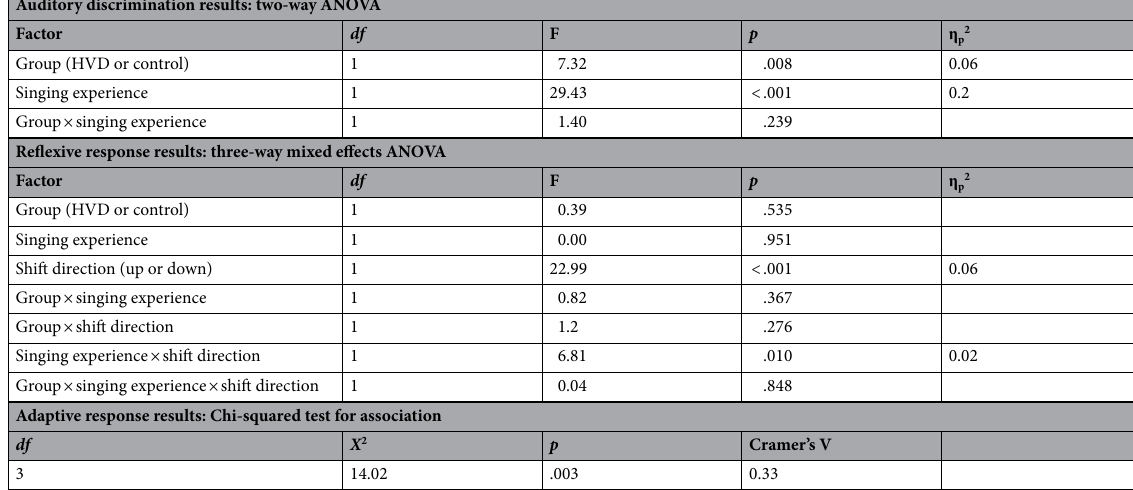
Table 1. Statistical results for each experimental task. HVD hyperfunctional voice disorder.